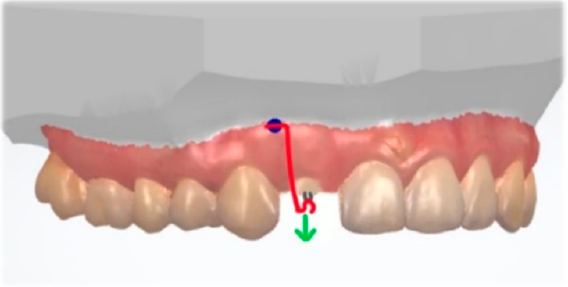
Figure 14. Extrusive force (green) applied along the long tooth axis with a cantilever (red) connected to the TAD (blue).